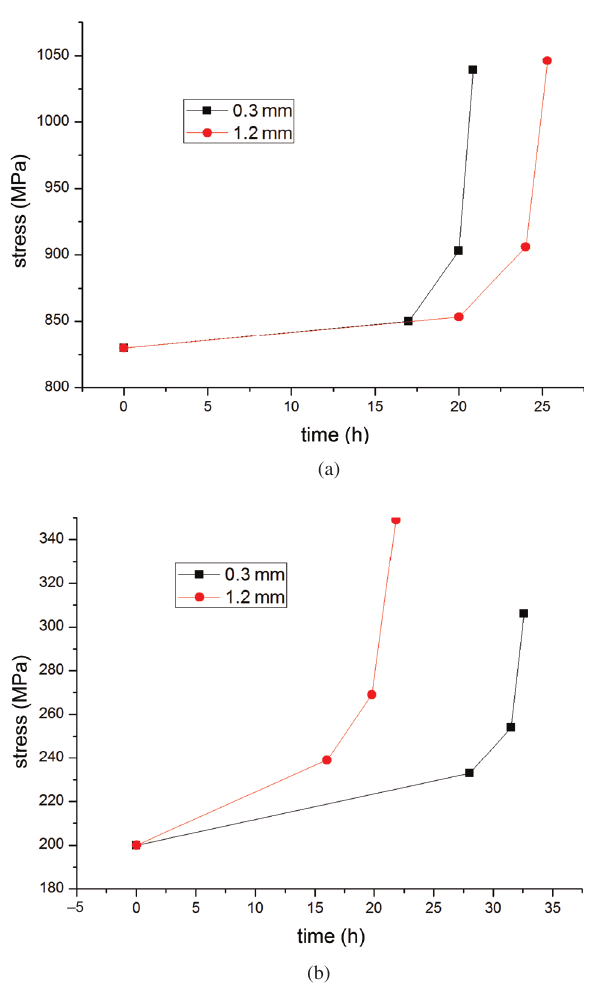
Figure 12: The tendency of the actual stress of the specimens with 0.3 mm and 1.2 mm. (a) 760 ℃ /830 MPa and (b) 1,100 ℃ /200